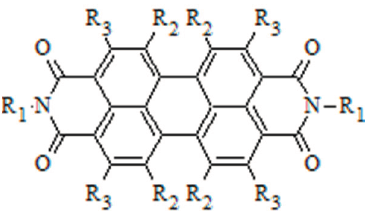
Figure 5. Perylene diimide (PDI) structure with imide (R 1 ), bay (R 2 ), and headland (R 3 ) positions labeled.